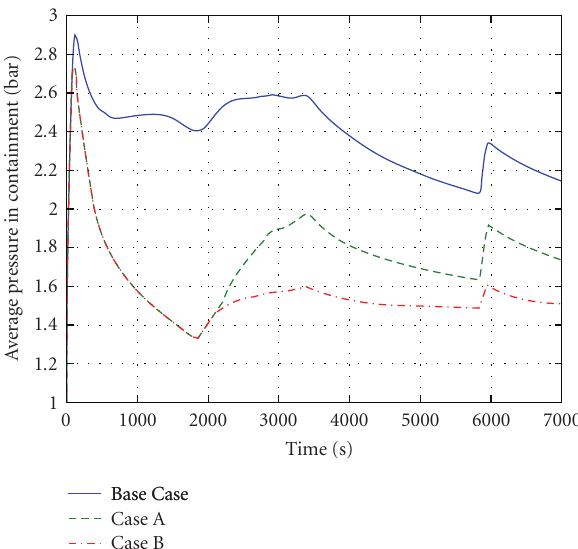
Figure 5: Average temperature variation.